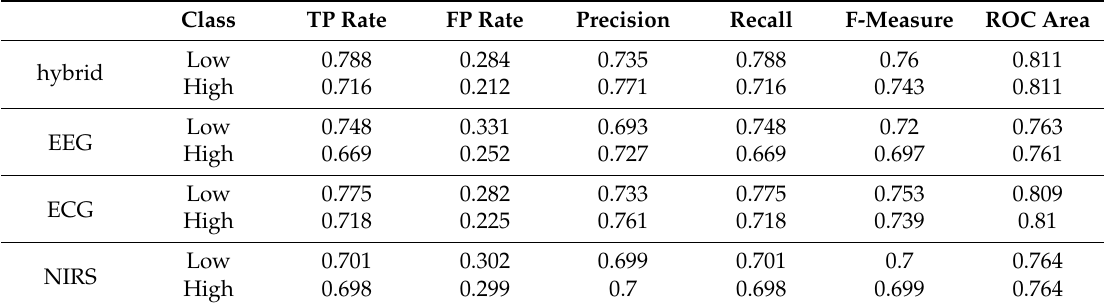
Table 7. Detail accuracy recognition during initial training.